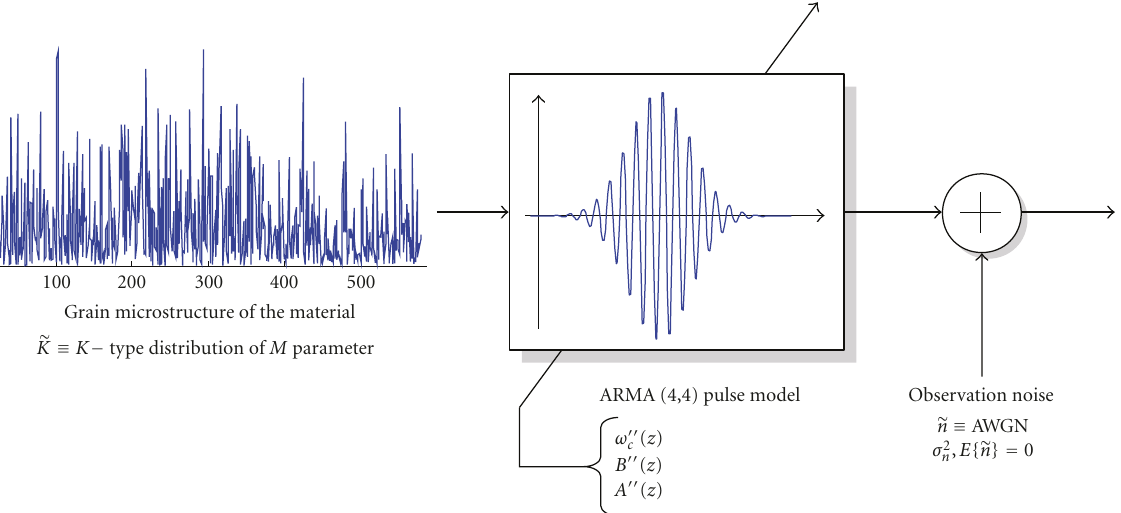
Figure 5: Linear time-variant model structure used for